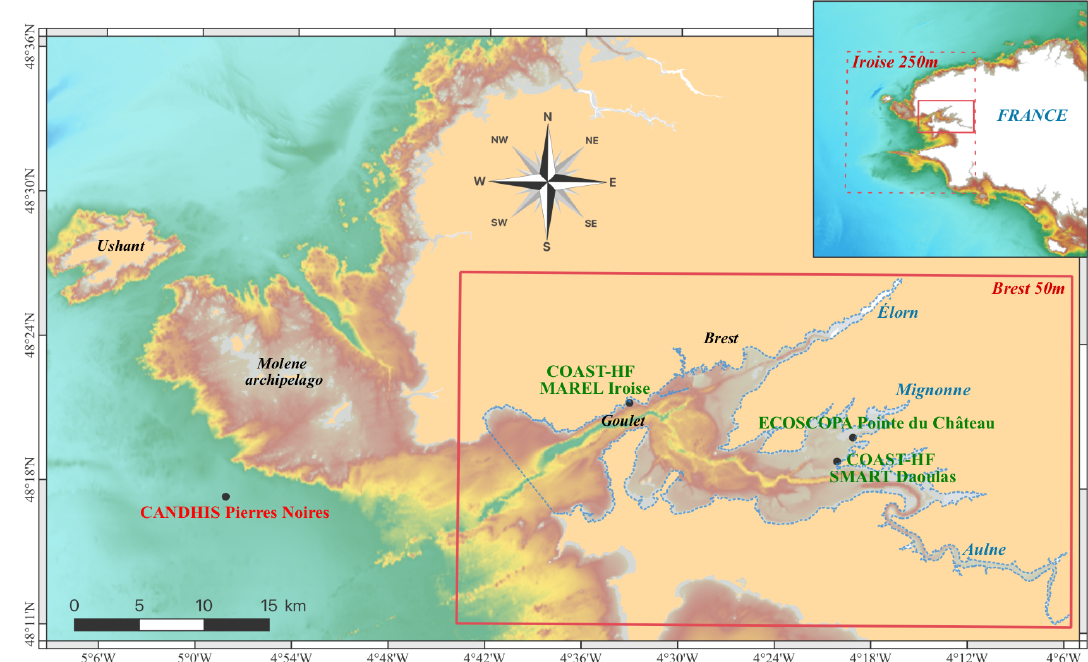
Figure 8. The bay of Brest configuration. The geographic extent of the magnified grid at 50m resolution is the solid red rectangle. The coarser grid at 250m resolution is the dashed red rectangle. The dashed blue line represents the control volume used for the estimation of the renewal indicator. Bathymetric and coastline sources: Ifremer